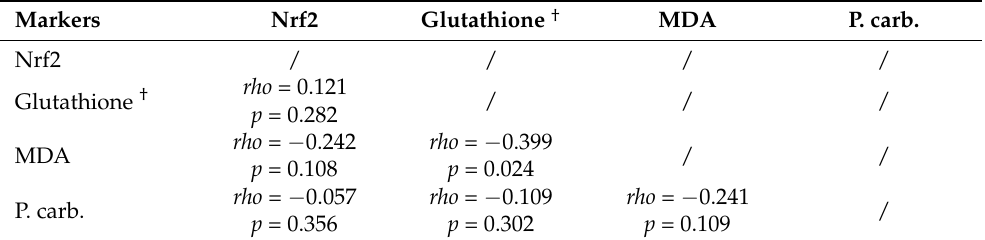
Table 3. Correlation matrix between circulating antioxidants markers and circulating oxidative damage markers in DMD